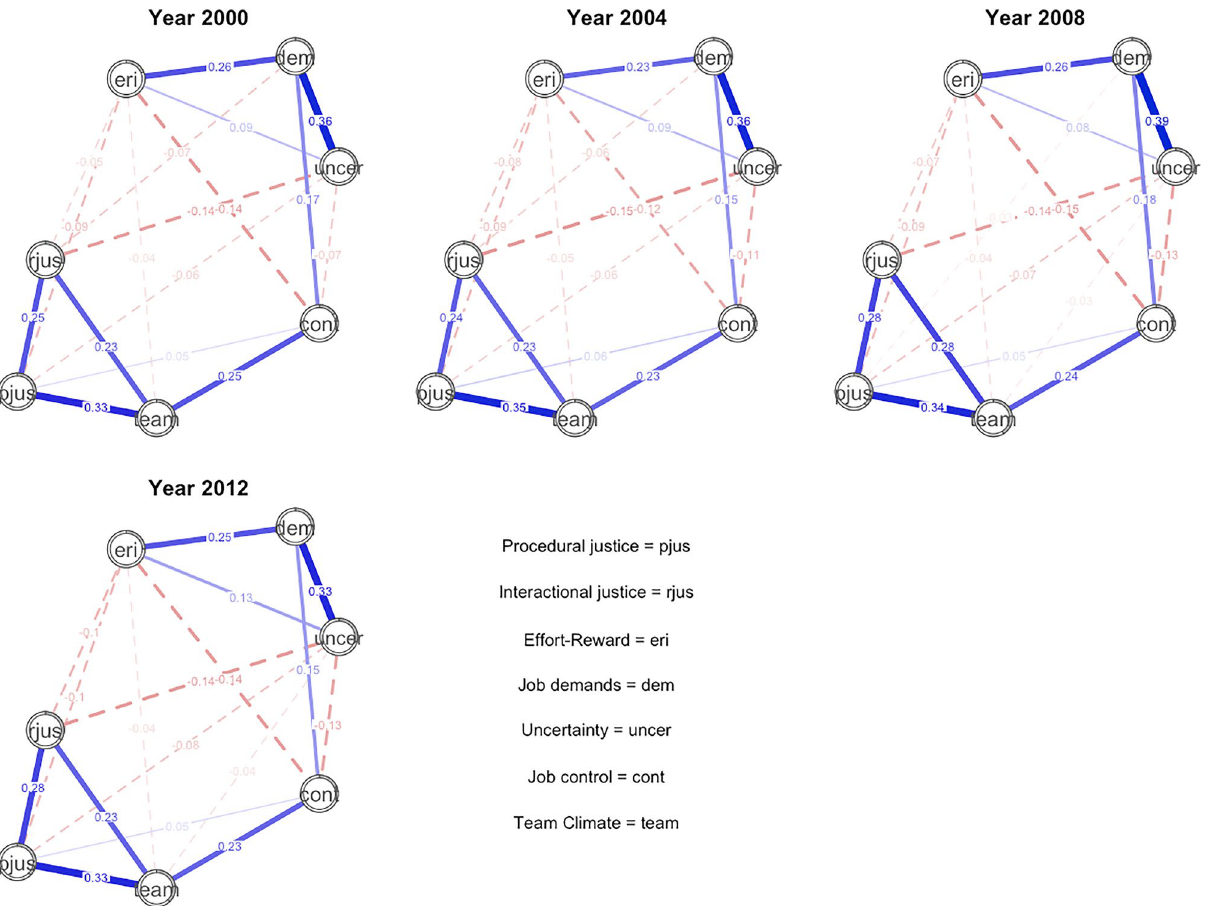
Figure 1. Cross-sectional networks for years 2000, 2004, 2008 and 2012 (procedural justice = pjus, interactional justice = rjus, effort-reward imbalance = eri, job demands = dem, job control = cont, uncertainty = uncer, team climate =